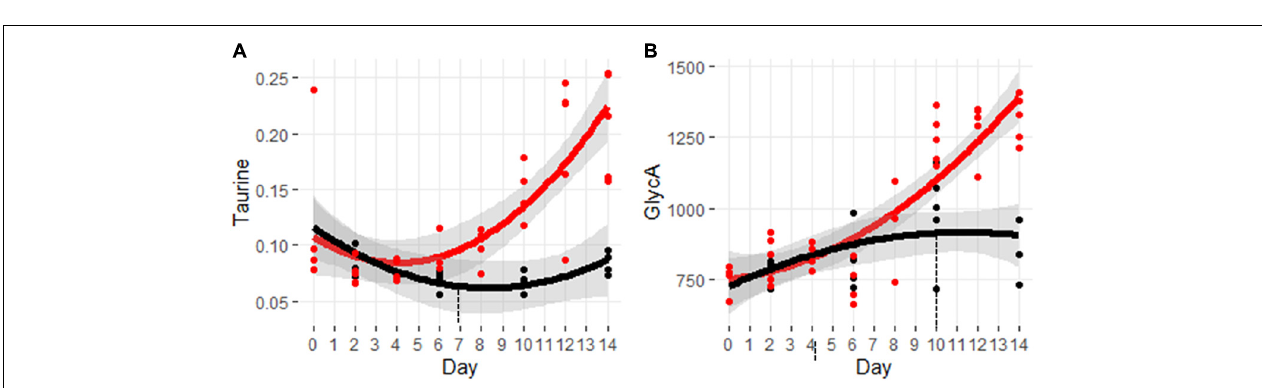
FIGURE 7 | Trajectory of markers for oxidative stress and inflammation. (A) Taurine and (B) GlycA. Black indicates control mice, red indicates cachectic mice, and the vertical dashed lines indicate the day in which the data were first significantly